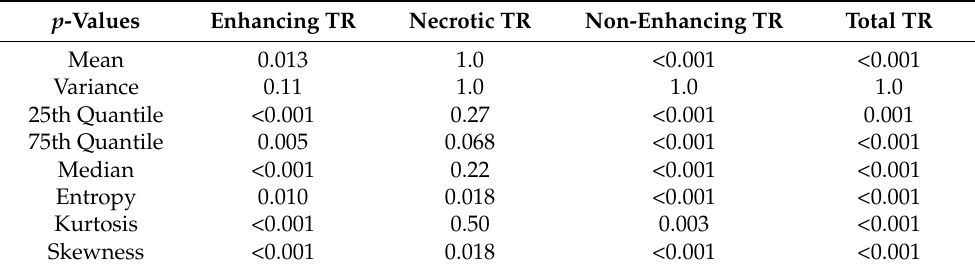
Table 2. Significances of the effects of free water correction on fractional anisotropy ( FA ) summary variables across tumor regions (TR) in grade IV patients. p ‐ values are calculated with a paired t ‐ test and a significance threshold of p < 0.05. The p ‐ values are adjusted for multiple comparisons using the Bonferroni method.